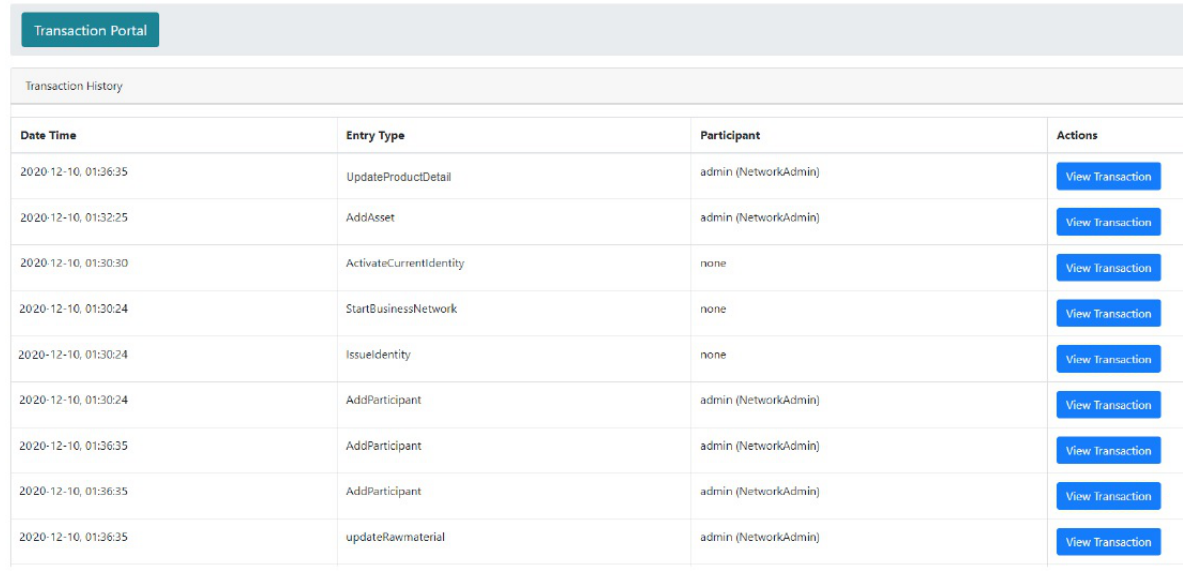
Figure 15. Transaction portal history